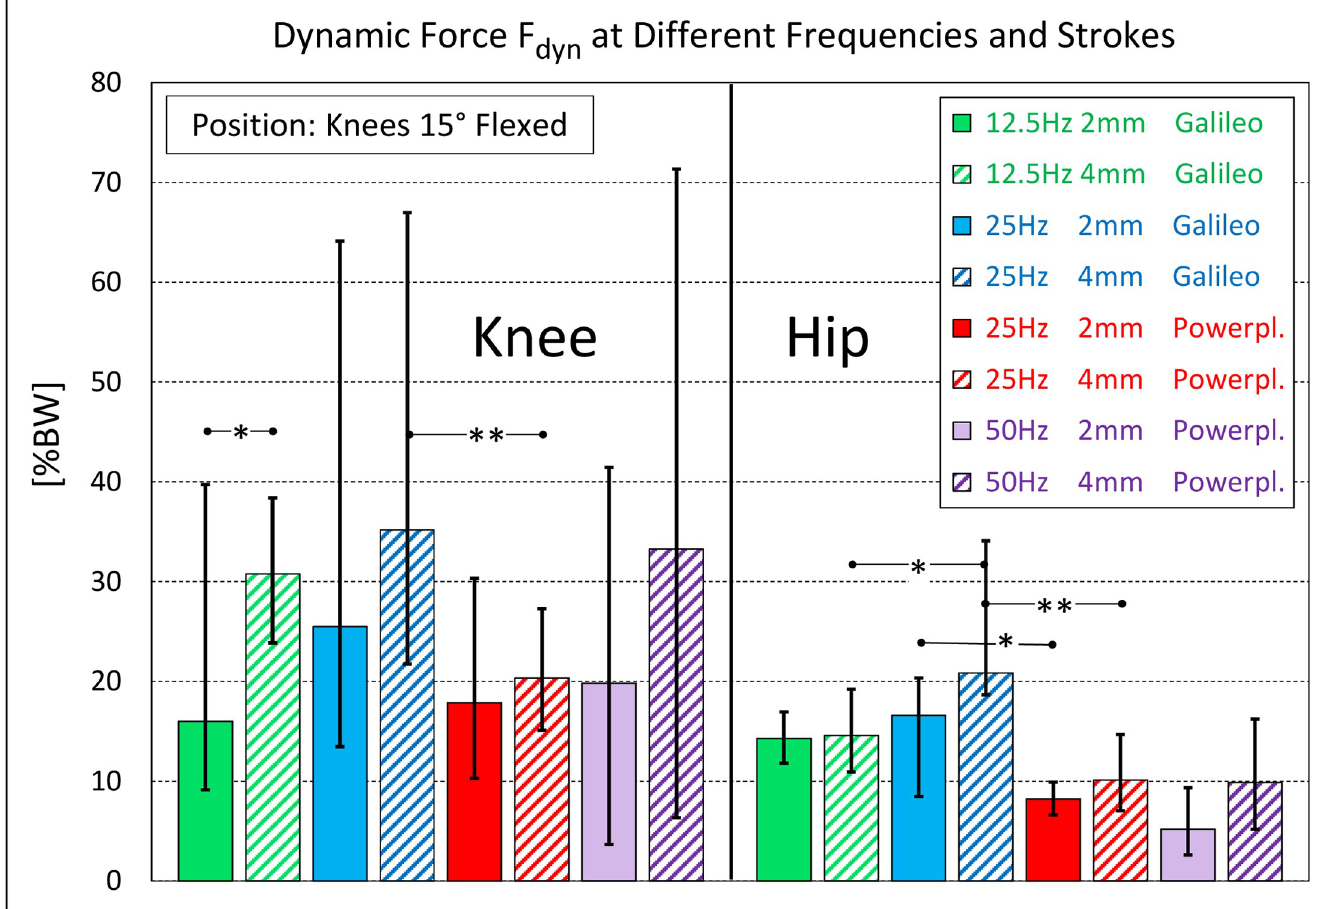
Fig 5. Dynamic force F dyn in knee and hip joint at different frequencies and strokes. Median values and ranges on Galileo and Powerplate. Body position = knees 15˚ flexed. �� = significant change (p � 0.05), � = low significance (p � 0.10).